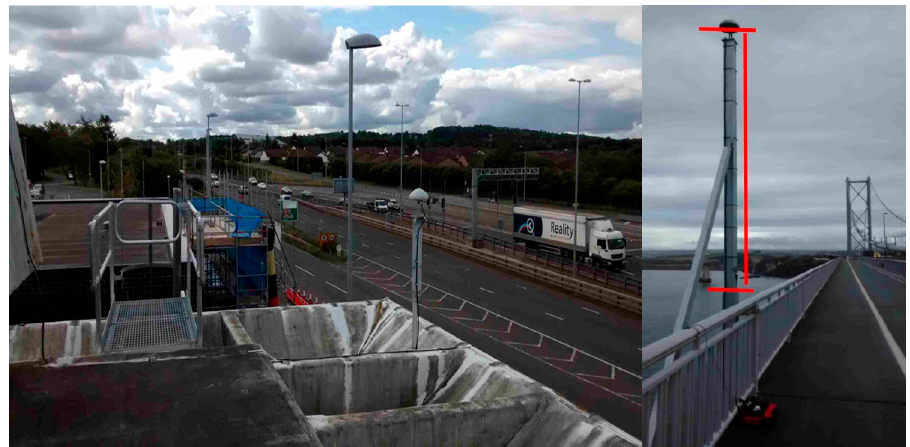
Figure 2. The distribution of base Figure 2 . The distribution of base stations . Figure 2 . The distribution of base stations . Table 1. The detailed information of the two baselines . Table 1. The detailed information of the two baselines .